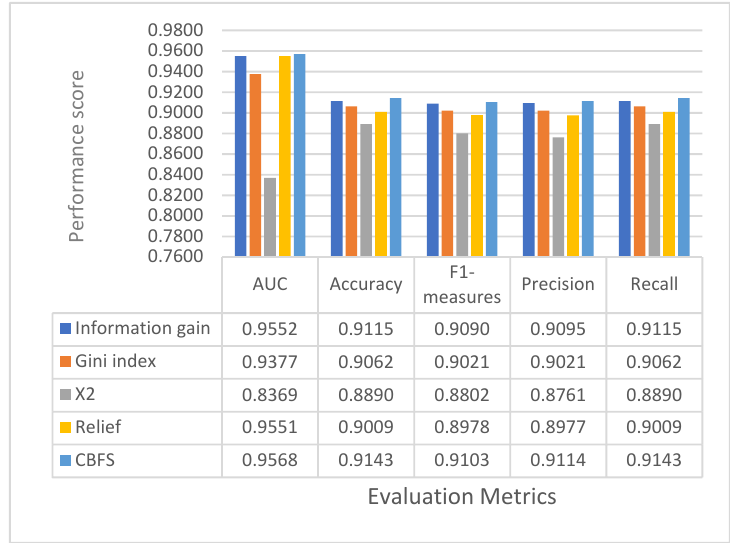
Figure 6. Performance of five feature selection methods on the lung ACPs using only 31 features.